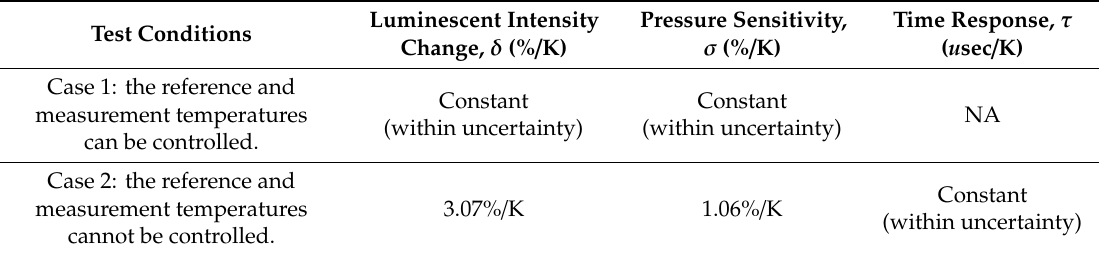
Table 1. Temperature e ff ect on the PC-PSP